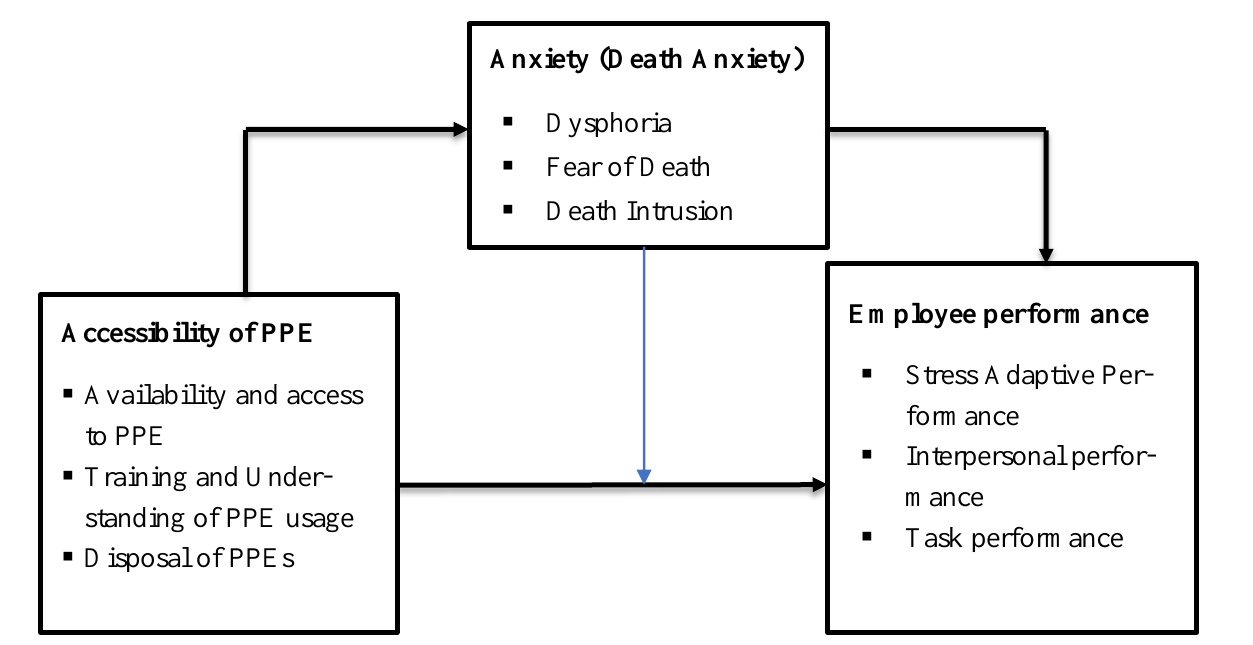
Figure 1. Conceptual framework.